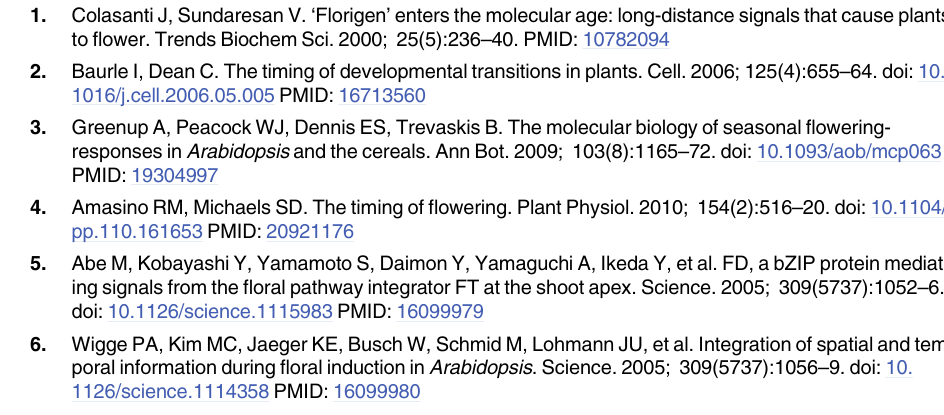
S1 Table. Primers used in this